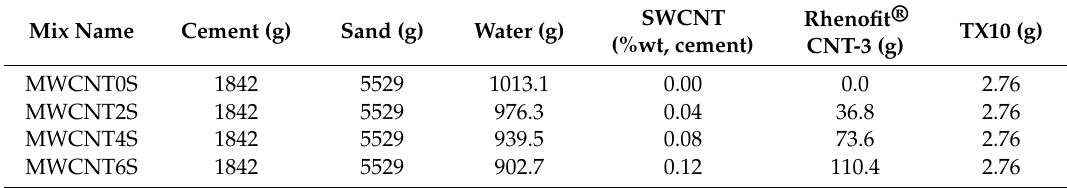
Table 9. Mix design of MWCNT-added mortar with treatment of